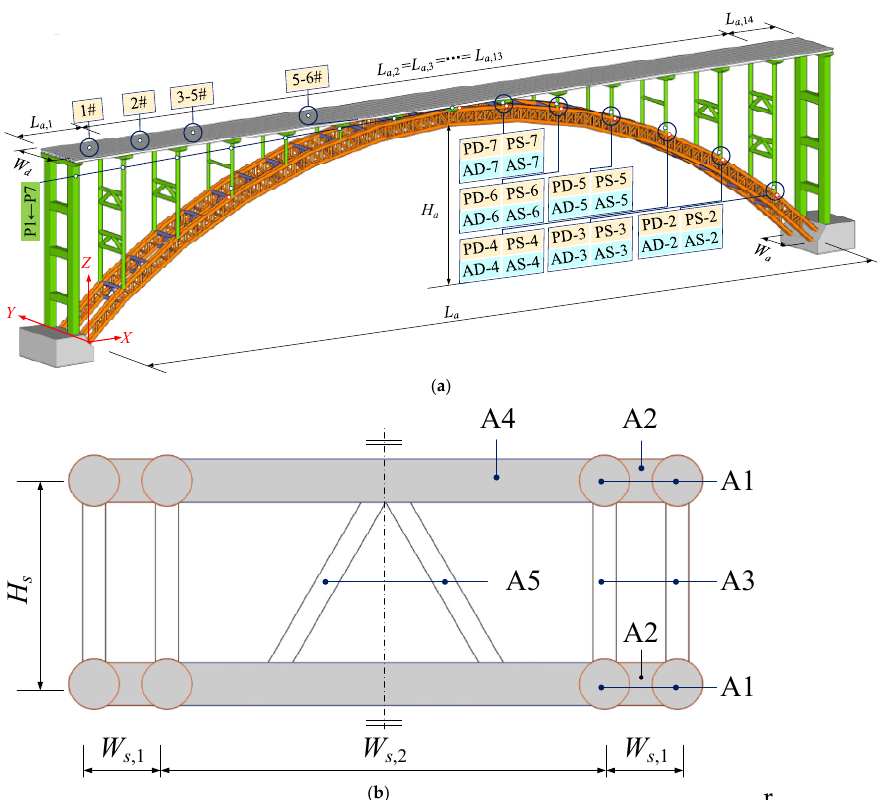
Figure 6. Layout diagram and sensor location of the bridge case. ( a ) Bridge layout. ( b ) Truss arch frame.